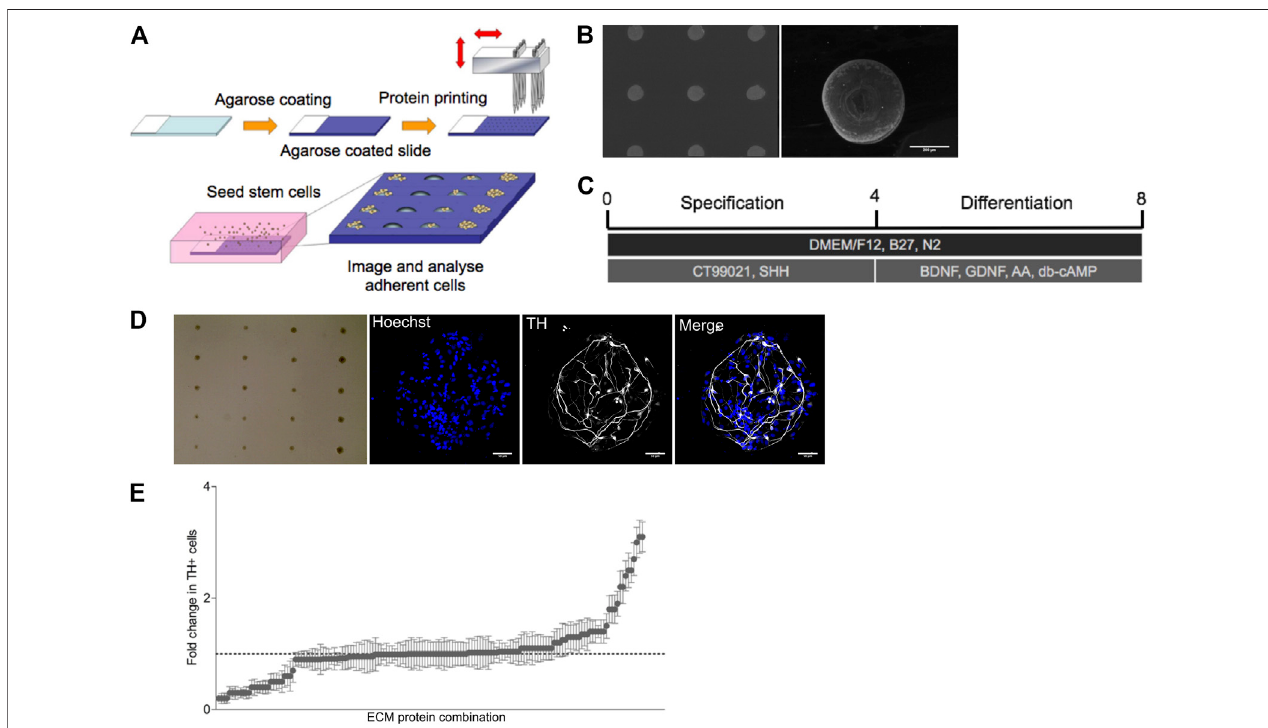
FIGURE 1 | ECM array generation and differentiation of Lt-NES into TH + neurons. (A) Graphical outline of screening strategy with ECM arrays. (B) Pan-laminin antibodystainingonarrayshowingauniformdistributionofECMproteins on approximately 200 µMspots onthe agarose coated glass slide. (C) Differentiationprotocol forhumanLt-NEScells. (D) Bright fi eldimageofanECMarrayseededwithLt-NEScellsinculturedisplayingthelocalizedgrowthofcellsinspotsseededacrosstheslide. Expanded fl uorescent images display nuclear staining (Hoechst) and tyrosine hydroxylase (TH) a marker for dopaminergic neurons (scale bar: 50 uM). (E) Results from ECM array presented as fold change in the percentage of TH + neurons compared to control laminin condition (laminin derived from EHS sarcoma). The x -axis displaysproteincombinationsdetailedin SupplementaryTableS1 orderedfromthosesupportingleastTH+neuronstothosecombinationswiththemost.Whilestthe majorityofcombinationsdisplayedcomparableratesofdifferentiationasthecontrolsubstrate,asmallnumberofECMproteincombinationswereabletoinducegreater differentiation.